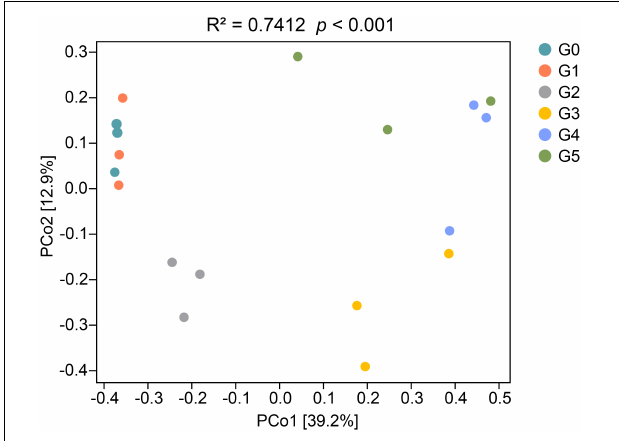
FIGURE 3 | PCoA (principal coordinates PCo1 and PCo2) analysis of the fungal communities based on the Bray–Curtis distance. PCoA ordinations were analyzed by